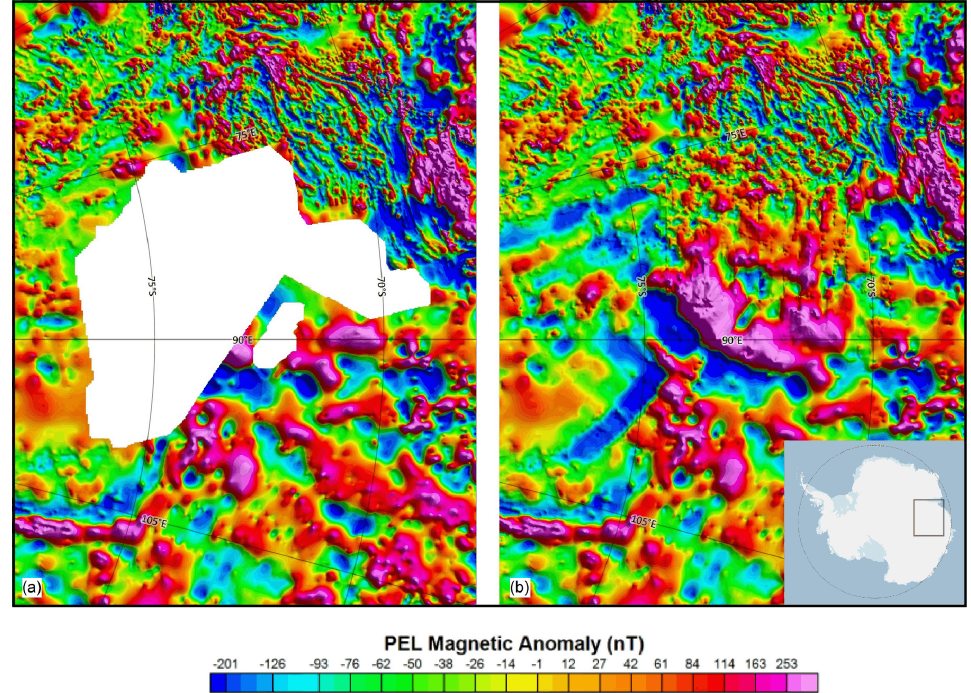
Figure 2. Comparison of aeromagnetic data from Snow Eagle 601 observation platform with ADMAP2 magnetic data. The ( a ) ADMAP2 data set (note that there is no data in the blank area), and the ( b ) data set after fusion of the aeromagnetic data obtained by Snow Eagle 601 fixed-wing aircraft.